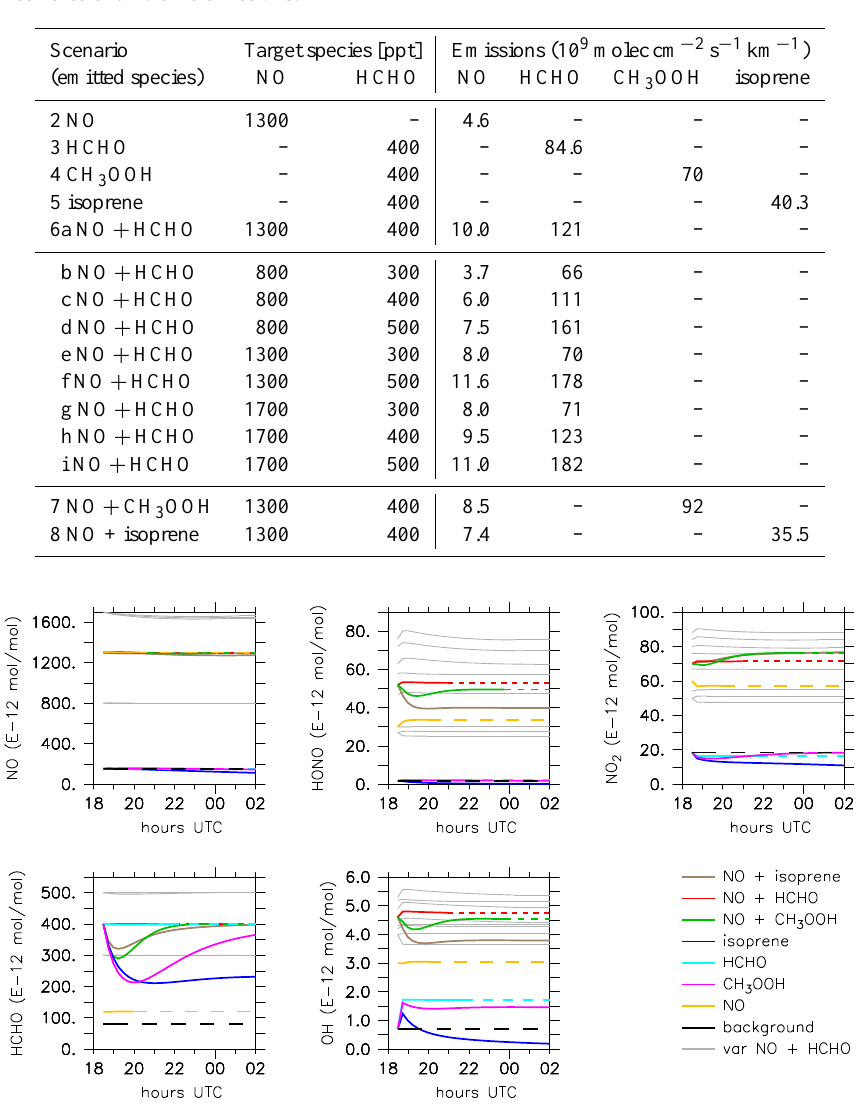
Table 8. Box model emission scenarios. NO emissions were adjusted to target the median mixing ratio of 1300ppt for NO as observed in situ by CARIBIC within the cloud. VOC emissions of HCHO, CH 3 OOH and isoprene were tuned to reach 400ppt of HCHO, the most likely mixing ratio within the cloud according to DOAS observations. We define 1300ppt of NO and 400ppt of HCHO as the standard for the situation within the cloud. However, NO and VOC emissions were also varied simultaneously to yield the first and third quartile for NO (0.8–1.7ppb), and the uncertainty lower and upper limit (300–500ppt) for HCHO (scenarios 6b–6i). The box model height was fixed to 1km for the conversion between area and volume emissions.